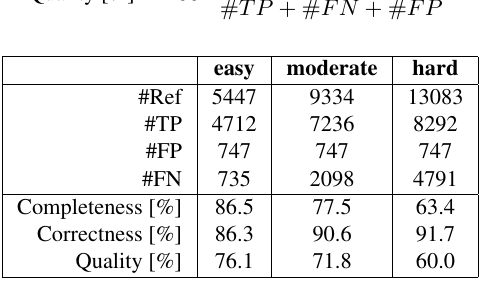
Table 2. Vehicle detection results.